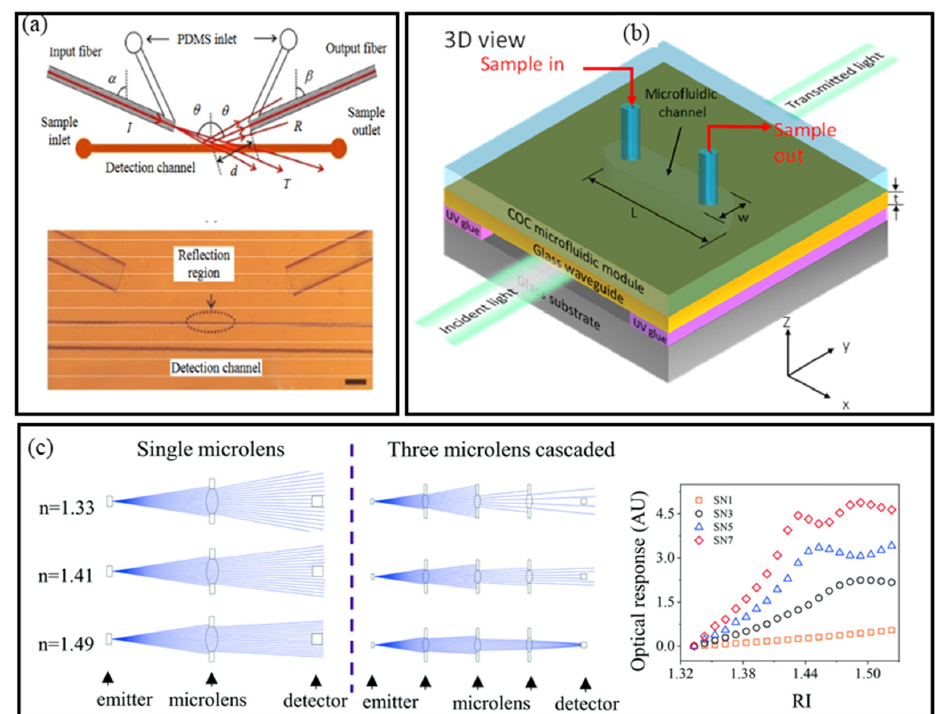
Figure 7. Optofluidic reflection and refraction for RI sensing. ( a ) TIR in a waveguide. ( b ) Reflection at the channel wall. ( c ) Refraction through a microlens or cascaded multiple microlenses. ( a ) Reprinted with permission from ref [75] Copyright 2017, Springer; ( b ) Reprinted with permission from ref [77], Copyright 2020, OSA Publishing; ( c ) Reprinted with permission from ref [33], Copyright 2021, Royal Society of Chemistry. Table 3. Comparison of the intensity-modulation-based optofluidic RI sensor in terms of configura- tion and performance.